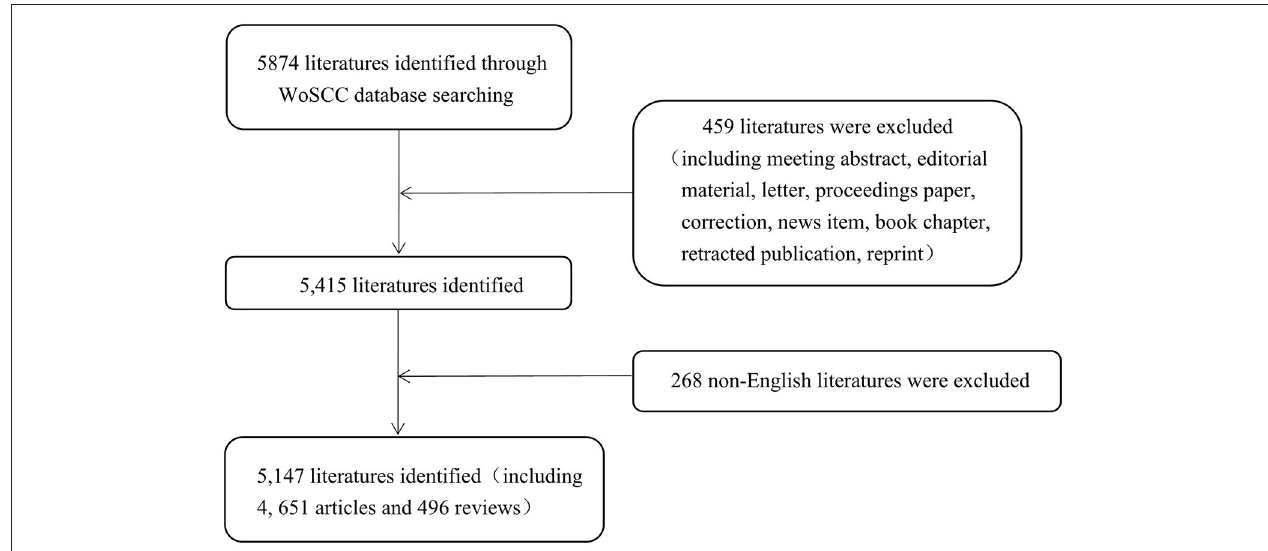
FIGURE 1 | Flow chart of literature filtering involved in this study.